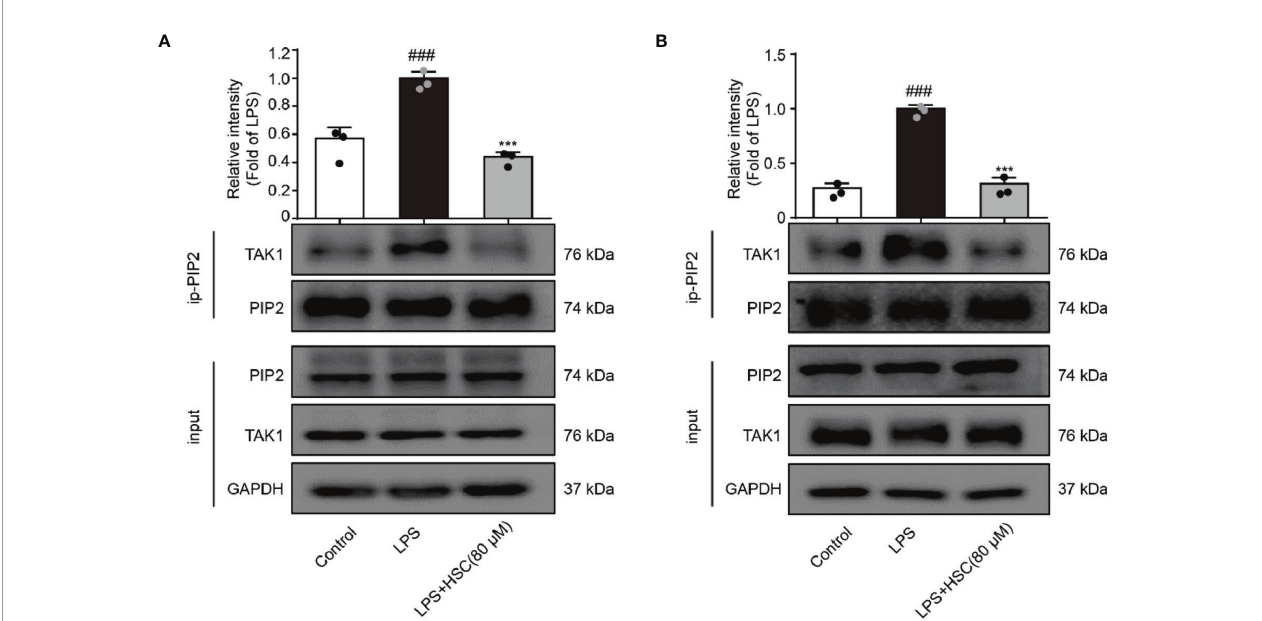
FIGURE 6 | HSC inhibits the activation of TAK1 via PIP2. RAW264.7 (A) , THP-1 (B) cells treated with HSC for 4 h, and then induced by LPS (1 m g/ml) for 1 h; The collected proteins were immunoprecipitated with PIP2 using magnetic beads, and immunocomplexes were determined by western blotting; ### P < 0.001 compared to control alone group; *** P < 0.001 versus the LPS group,